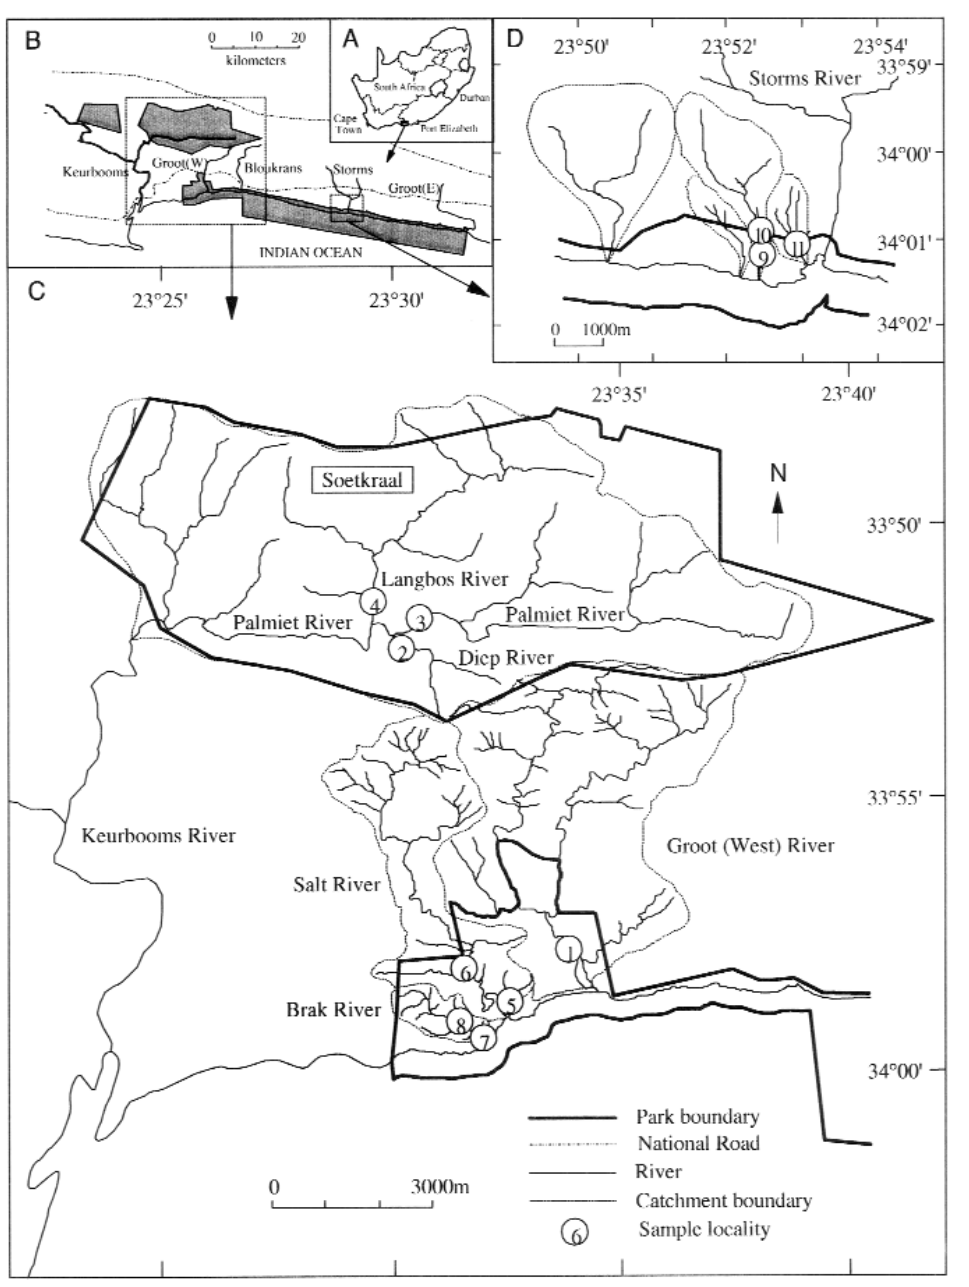
Fig 1. Location of the Tsitsikamma National Park relative to major centres (A) and geographical features (B), and location of study sites in the Keurbooms, Salt, Brak and Groot (West) rivers (C) and two unnamed rivers in the vicinity of the Storms River